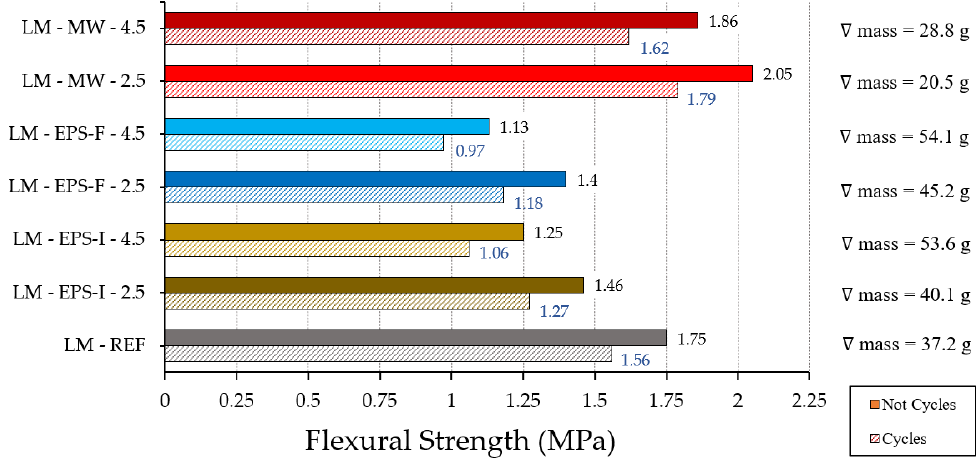
Figure 11. Results of the freeze–thaw test. Flexural strength of samples subjected to freezing cycles (striped stripes) and reference samples (solid stripes), including loss of mass.